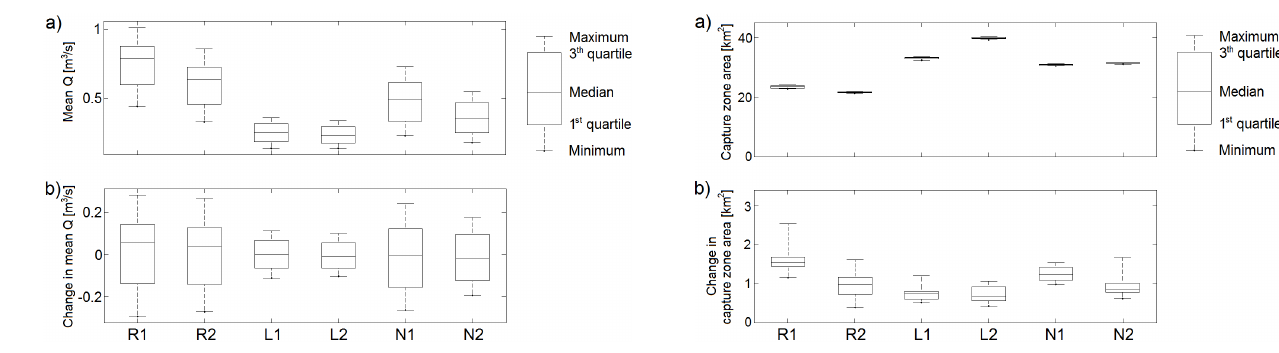
Figure 6. (a) Box plot of the simulated mean summer stream dis- charge ( Q s ) in a downstream discharge station (st. 52.30) using in- put from 11 climate models, and (b) box plot of the change in Q s from reference to future scenarios.